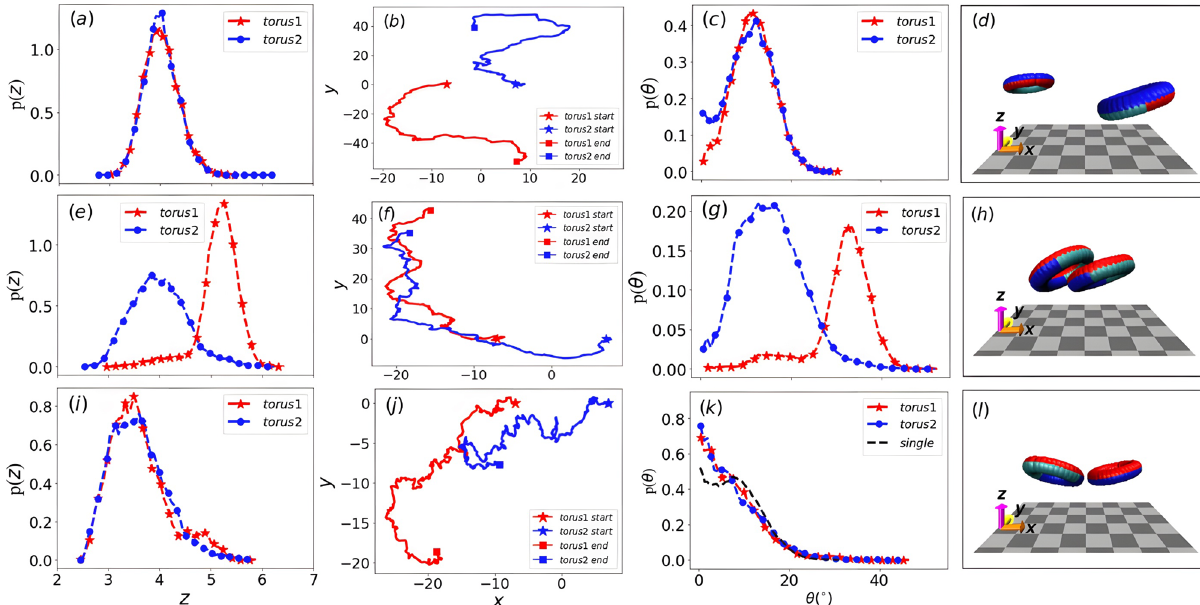
Fig. 4 Bound states of two tori near the wall. a – d Backward-moving tori with g = 0.15 and ϵ c d = 0.2; e – h forward-moving tori with g = 0.07 and ϵ c d = 0.2; f – l forward-moving tori with g = 0.09 and ϵ c d = 0.2. The panels ( a , e , i ) are the probability distribution P ( z ) versus the hovering height z , b , f , j are the trajectories of the centers of mass of the two tori, c , g , k are the probability distribution p ( θ ) versus the tilt angle θ , d , h , l an instantaneous con fi guration of the two tori. The probability distributions were constructed from 30 – 40 realizations of the dynamics. The red colour indicates the catalytic surface. The blue/green facets correspond to the non-catalytic surface. The torus moves with the blue facet g = 0.07 (again the same parameter values as in Fig. 2 for a single torus), and a larger value g = 0.09. The results for g = 0.07 in Fig. 4e – h indicate that the P ( z ) and p ( θ ) distributions of the individual tori are no longer the same, as was the case for backward-moving tori. On average, one torus lies at a distance farther from the wall than the other; also the tilt angle is larger for the upper torus. The plot of the probability density, P ( D ), in Fig. 5a, shows that the D values are concentrated between D = 7.0 and 10.0. Since a torus has a centerline radius a = 5, this indicates that the two tori form a stacked bound state. These features are